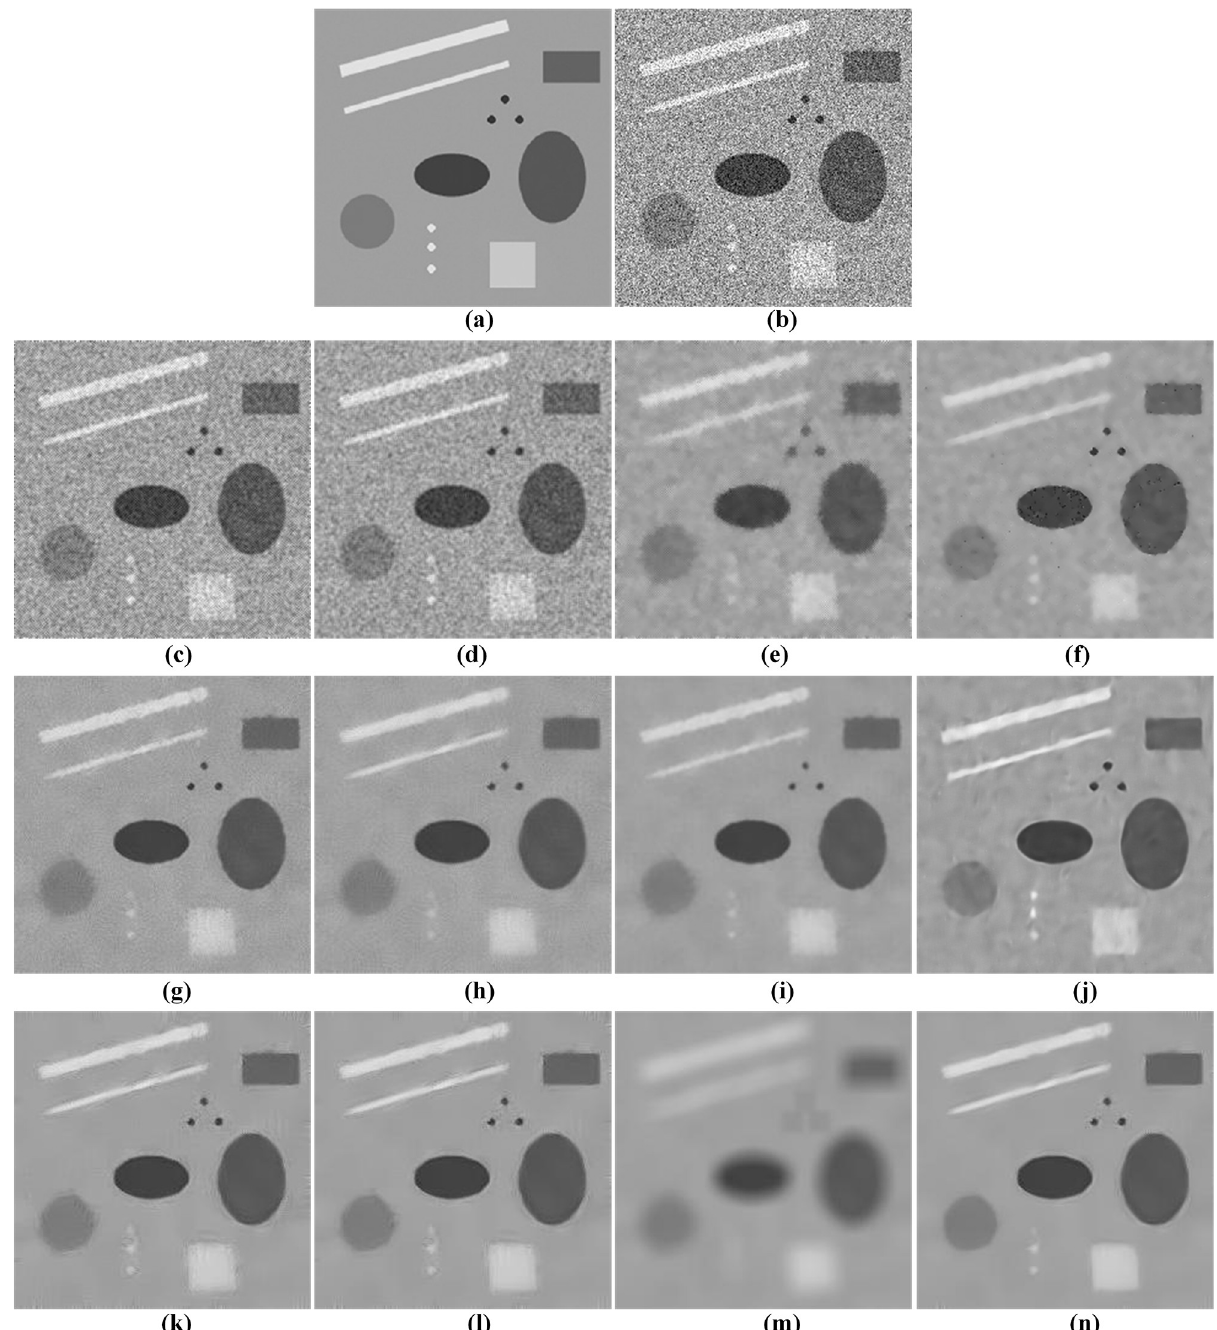
Fig 5. Visual comparison of restoration performance of the various despeckling methods on the synthetic image. (a) original image, (b) synthetic image with speckle noise ( σ = 3), (c) Frost filter, (d) Kuan filter, (e) SBF filter, (f) SRAD filter, (g) TNLM filter, (h) OBNLM filter, (i) NLMLS filter, (j) DnCNN filter, (k) OPCA-NLM filter, (l) RPCA-NLM filter, (m) SPCA-NLM filter, and (n) PPCA-NLM filter.